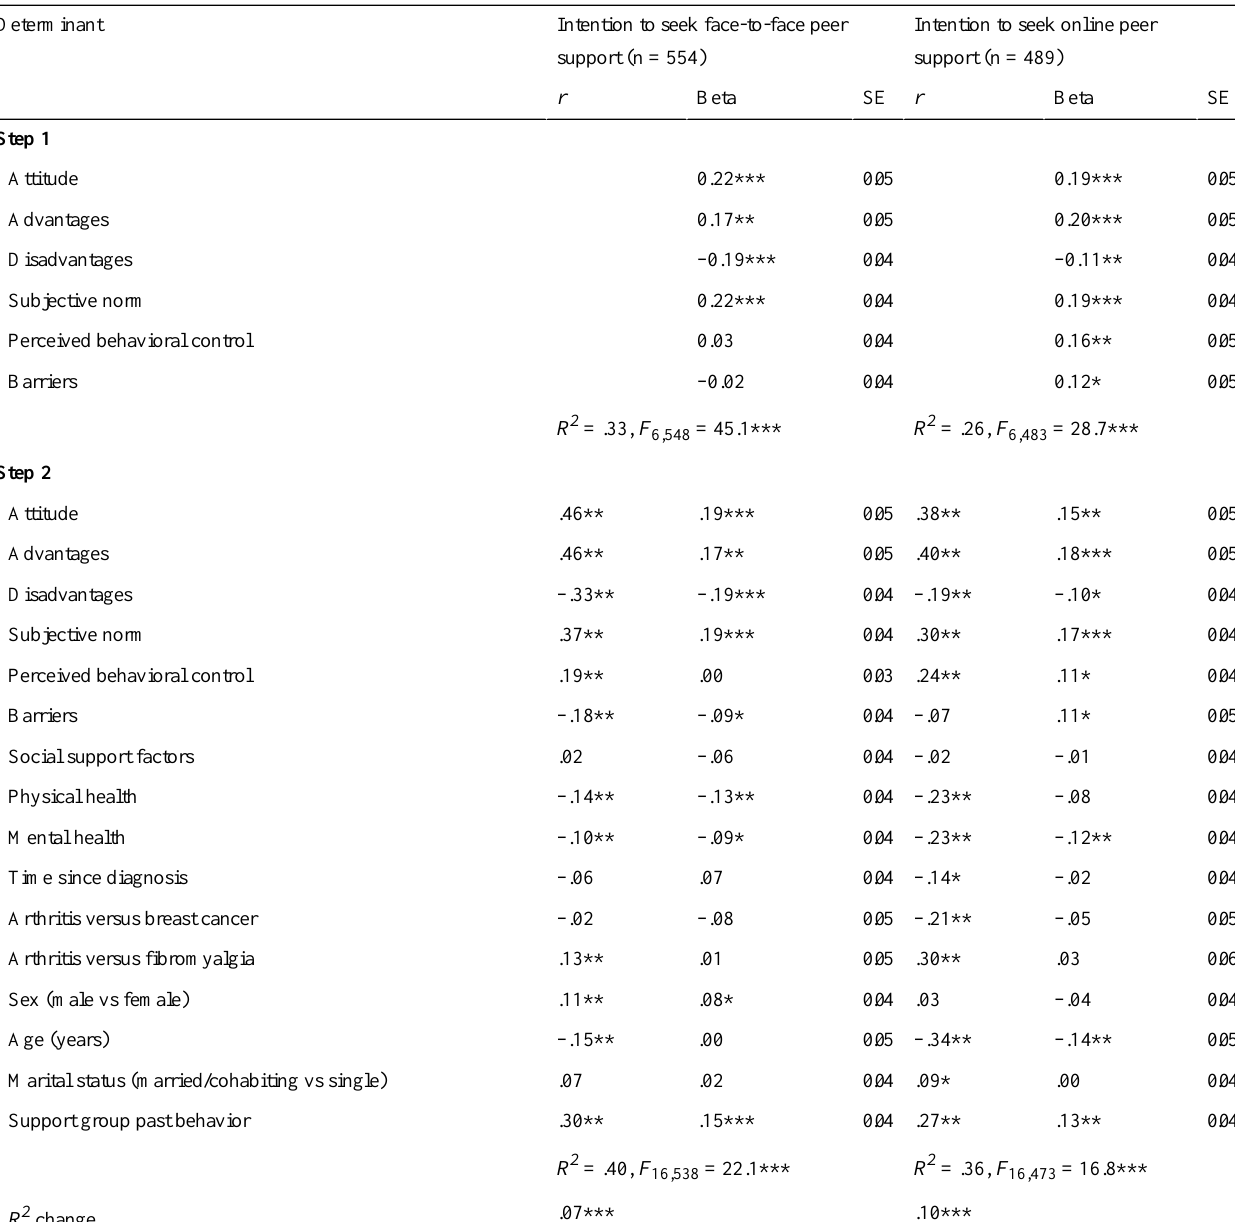
Table 6. Extent to which intention to seek online peer support and face-to-face peer support can be predicted by determinants of the theory of